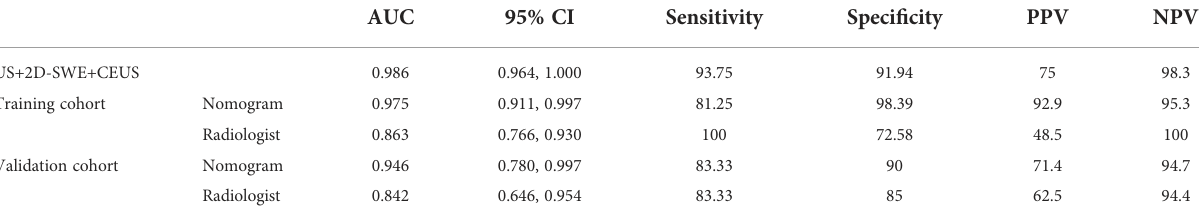
TABLE 5 The diagnostic performance of the US+2D-SWE+CEUS, nomogram, and radiologist.